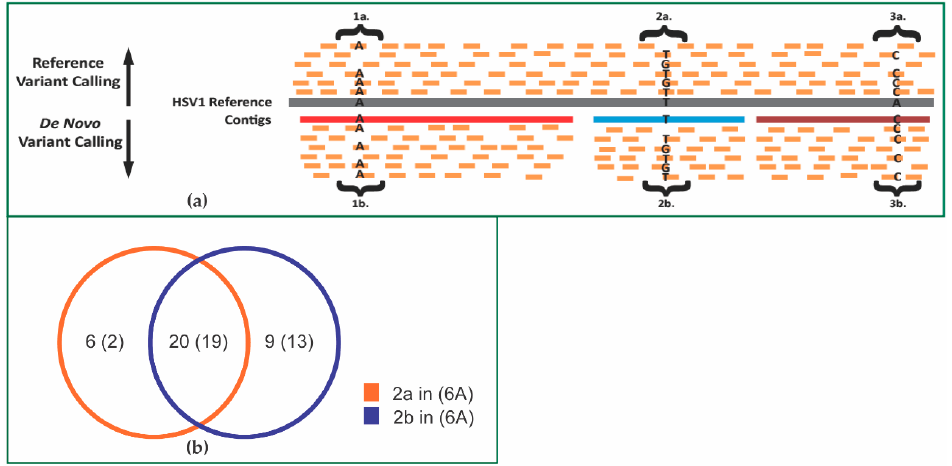
Figure 6. Determination of polymorphic sites. ( a ) Sites 1a, 2a and 3a represent specific loci with multiple reads aligned to the reference using a reference-based approach. (1a) A locus where all read sequences agree with the reference sequence. No variant is identified. (2a) A locus with polymorphic read sequences compared to the reference. A variant segregating in the population will be identified.